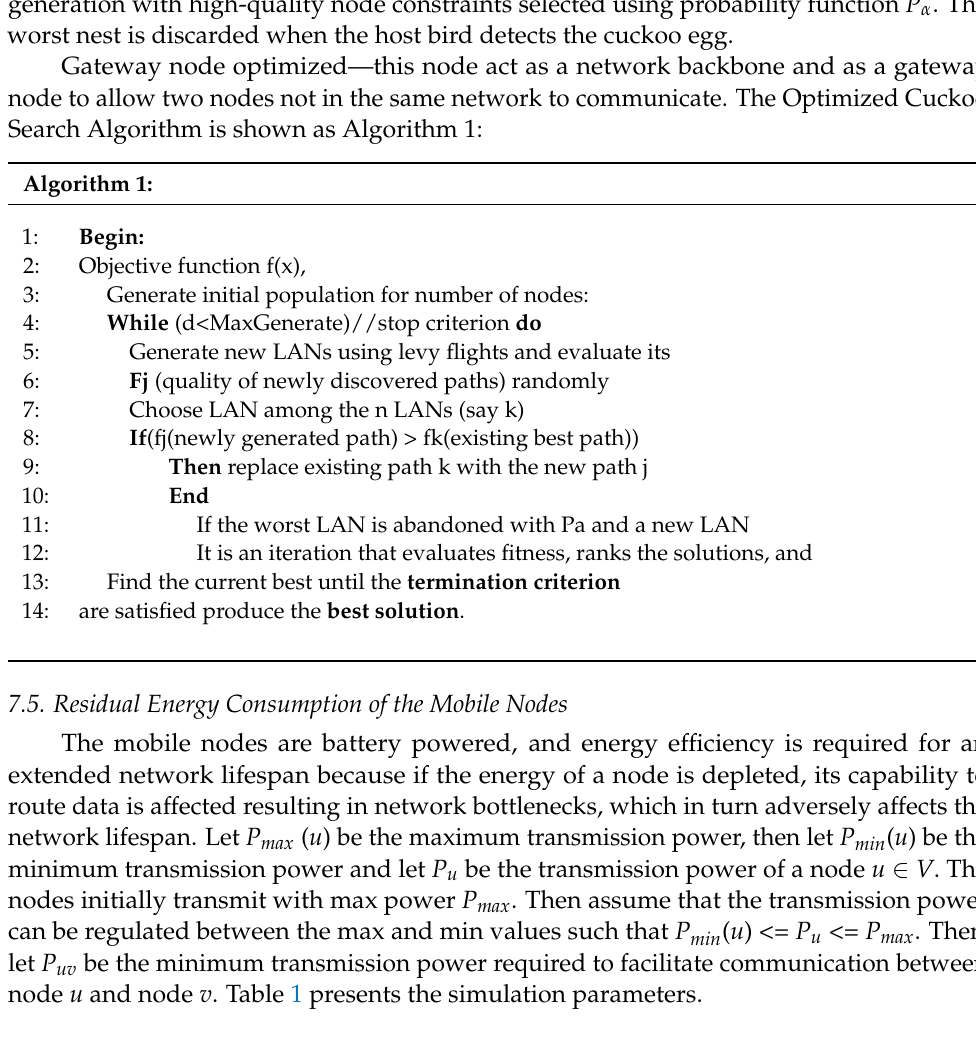
Table 1. Simulation